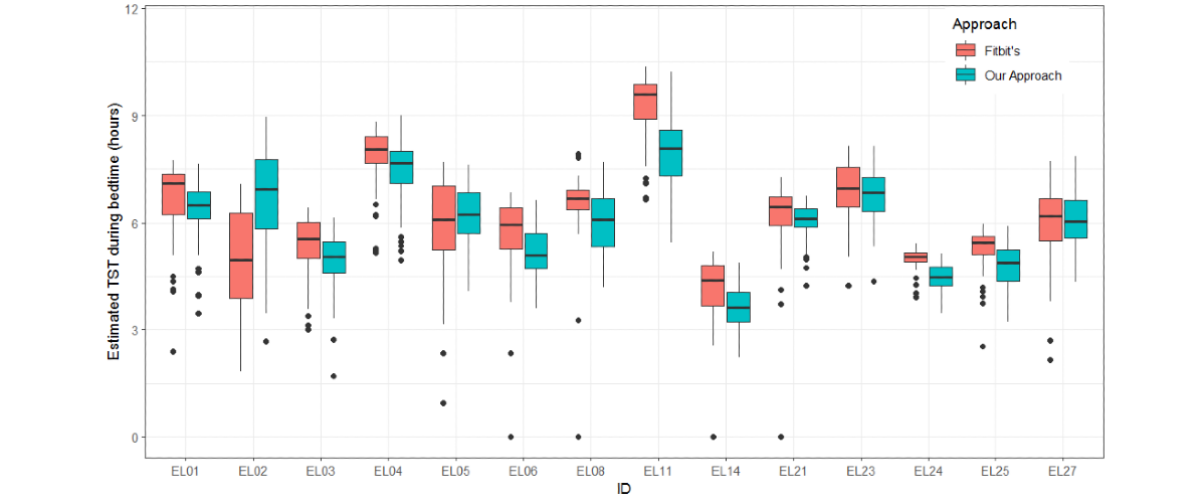
Figure 8. Boxplot of estimated daily total sleep time during bedtime at night from our approach and Fitbit’s approach for all participants. HMM: hidden Markov model; TST: total sleep